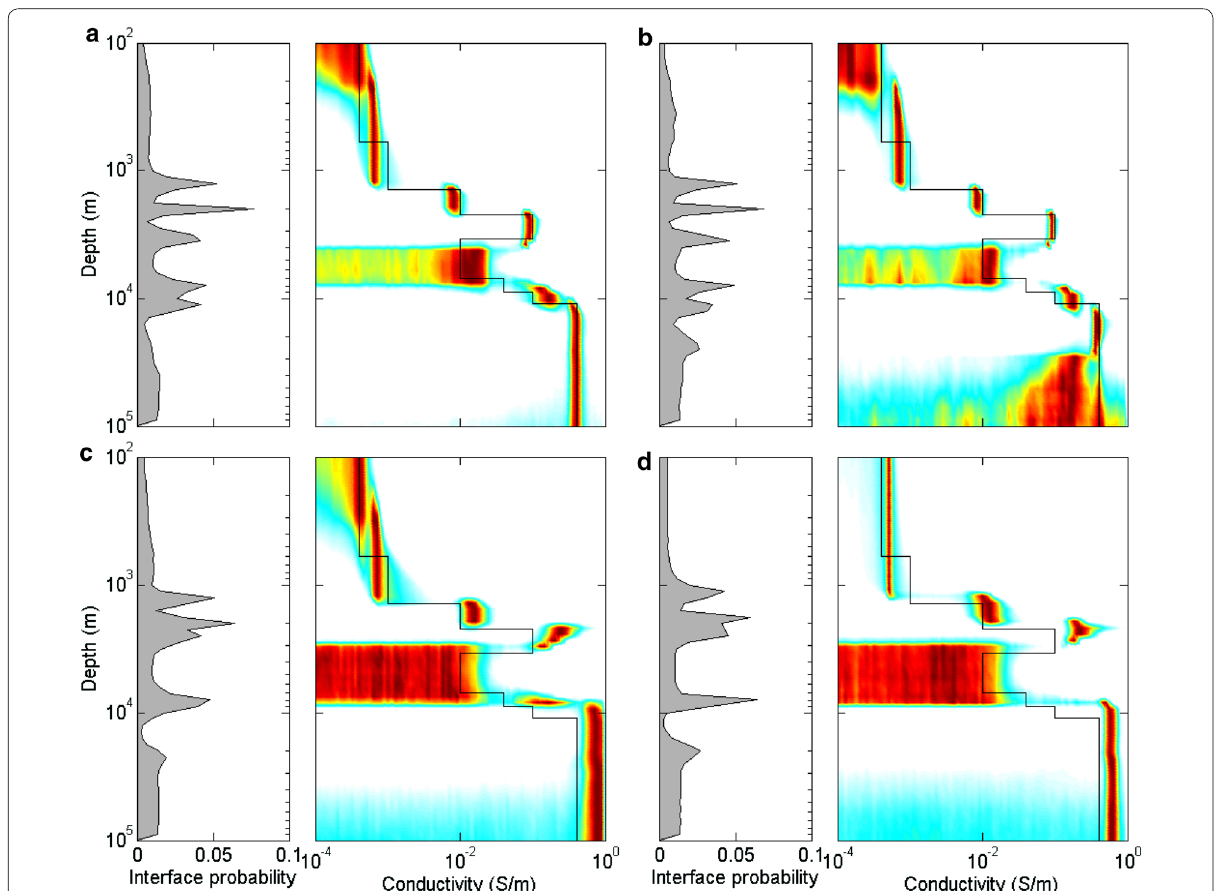
Fig. 1 Marginal profiles of the interface depth and conductivity for the eight-layer case from the inversions ( a , c ) with and ( b , d ) without considering error correlations. The upper panels are for the AR(1) parameter a